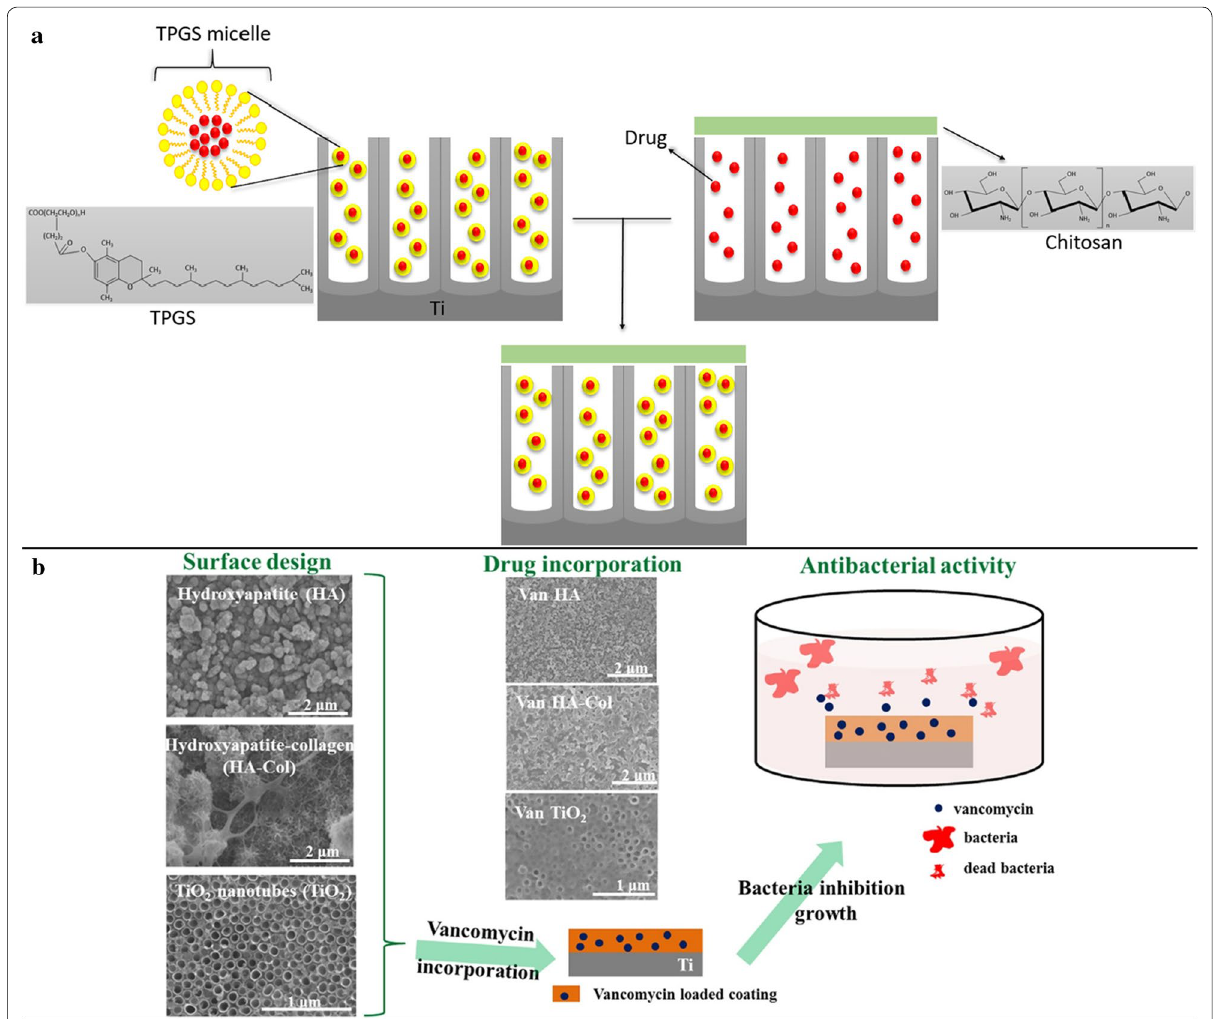
Fig. 4 Schematics showing how coated TNTs may present stabilized drugs in their tubes and how some materials are applied to these coatings ( a ), reprinted with permission from Elsevier, (Oliveira et al. 2017). Scheme showing how the release of drugs influences the behavior of bacteria ( b ), reprinted with permission from Elsevier, (Ionita et al.